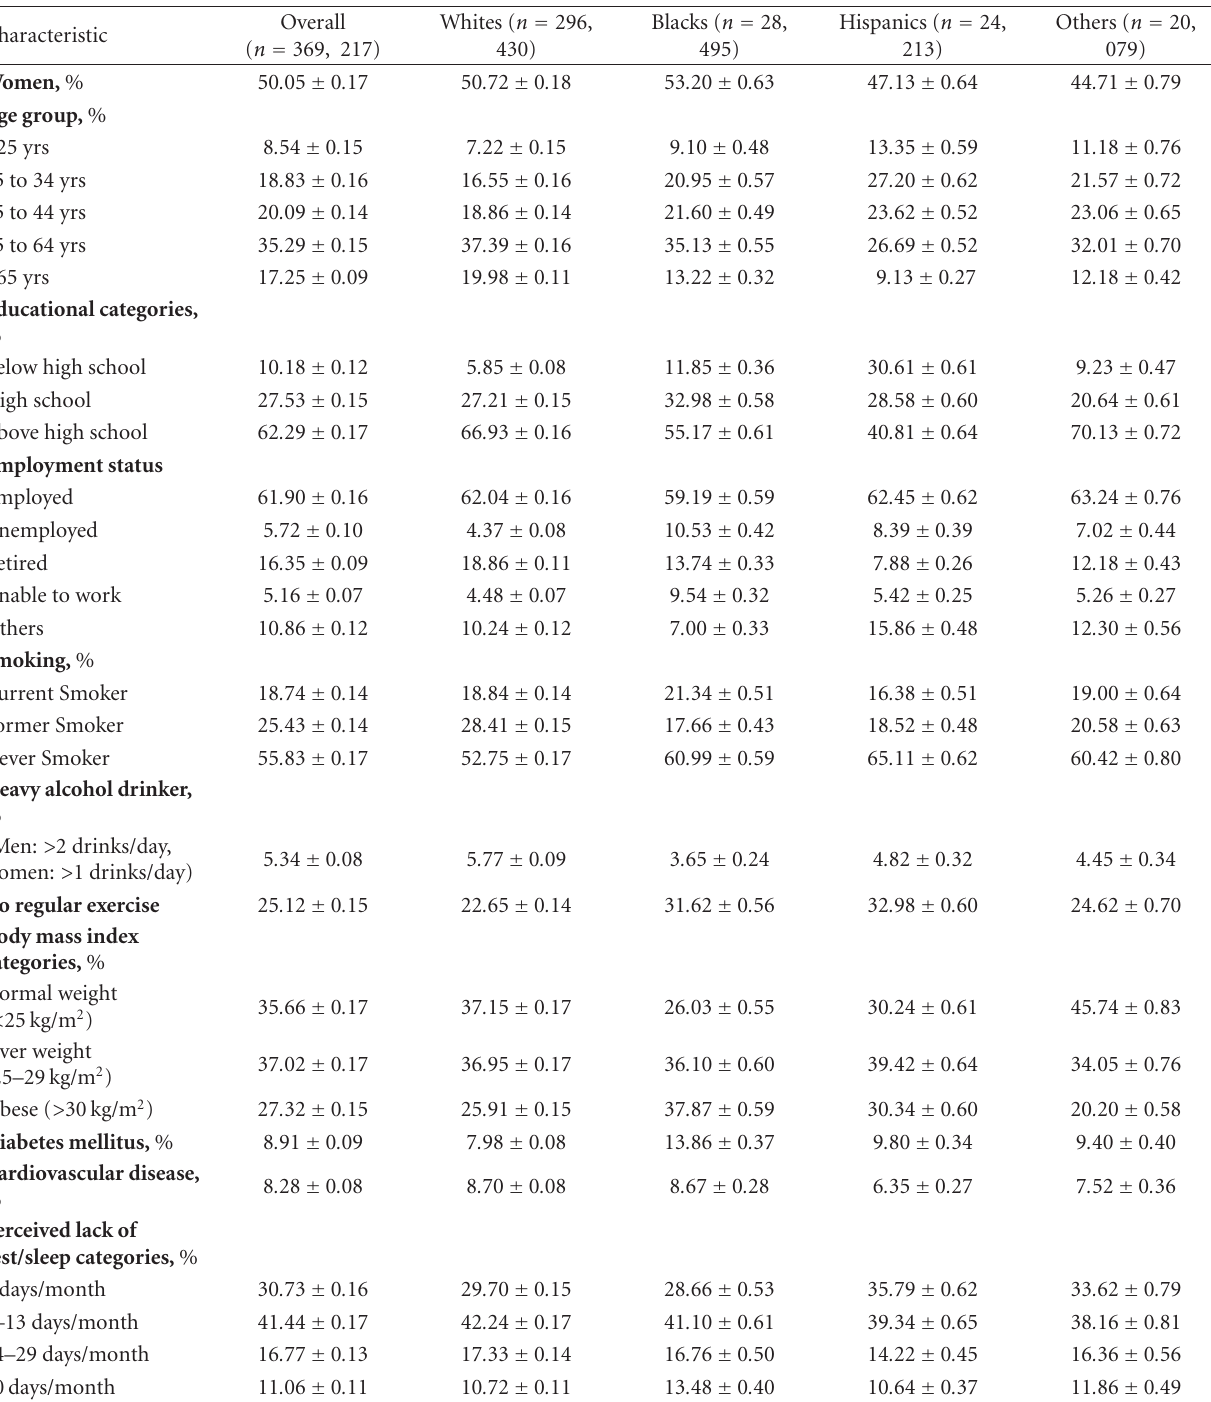
Table 1: Baseline Characteristics of study populations (percentages ± standard errors, SE) ( n = 369,217).